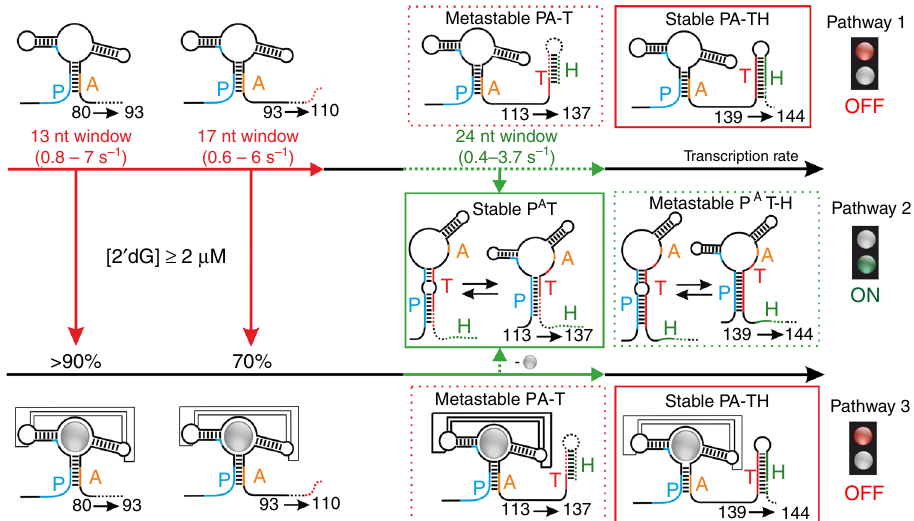
Fig. 1 Non-equilibrium model for the co-transcriptional conformational switch of the 2 ′ dG-sensing riboswitch. Regulatory function by transcriptional riboswitches is based on a ligand-dependent interplay between the four sequence segments P (5 ′ -aptamer strand), A (aptamer-stabilizing strand), T (switching strand), and H (terminator strand) 15 . Previously derived transcription intervals for folding events involving a stabilization of the aptamer domain via the P – A interaction or switch in strand interaction (A – T interaction) are highlighted in red (ligand binding) and green (ON state folding), respectively. Directly after transcription of the aptamer domain, 2 ′ dG can bind during the synthesis of nts 80 – 110 (30 nt window), with a continuous decrease in the ligand binding ef fi ciency from >90% to 70% between nucleotides 93 and 110. Continuation of transcription beyond nt 113 transforms both the ligand- bound and ligand-free aptamer domains (PA – T) into metastable states (dashed red box). Folding to the regulatory ON state (P A T, solid green box) can only occur during synthesis of nucleotides 113 – 137. At the regulatory decision point, folded P A T – H states are metastable (dashed green box), while the PA – TH conformation (solid red box) represents the lowest free energy state in both absence and presence of ligand. Metastable states are highlighted by dashed boxes and lowest free energy states by solid